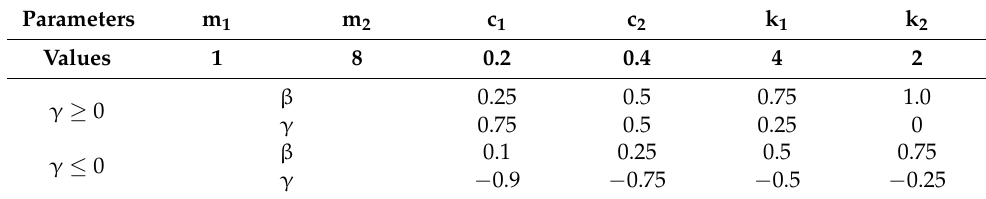
Table 1. Value table of the model control